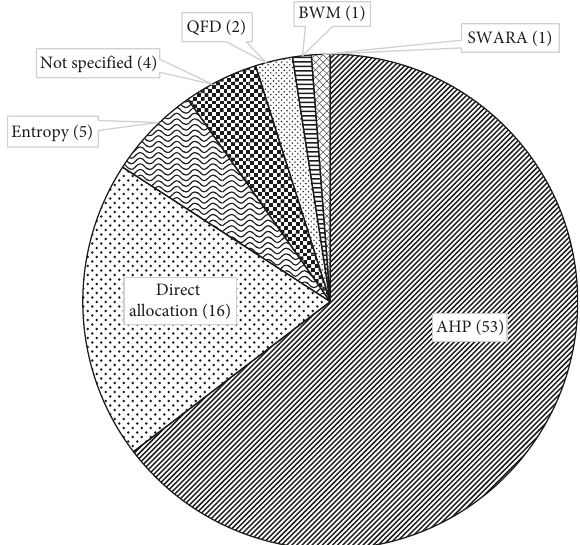
Figure 3: Weighting techniques applied within the reviewed